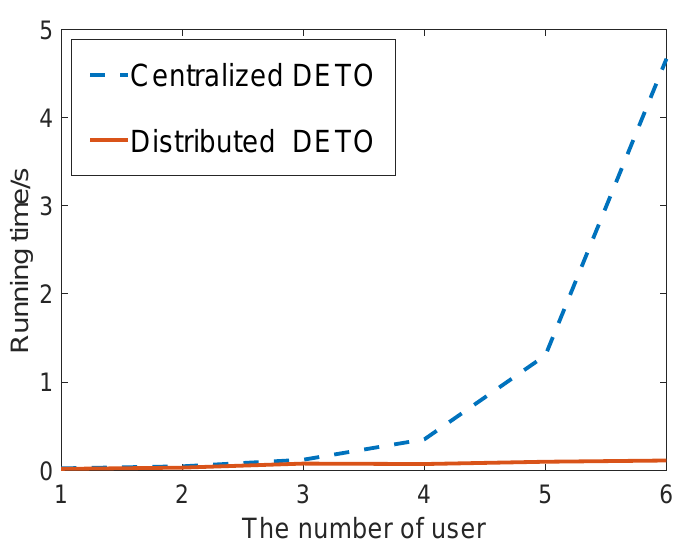
Figure 6. The average delay.